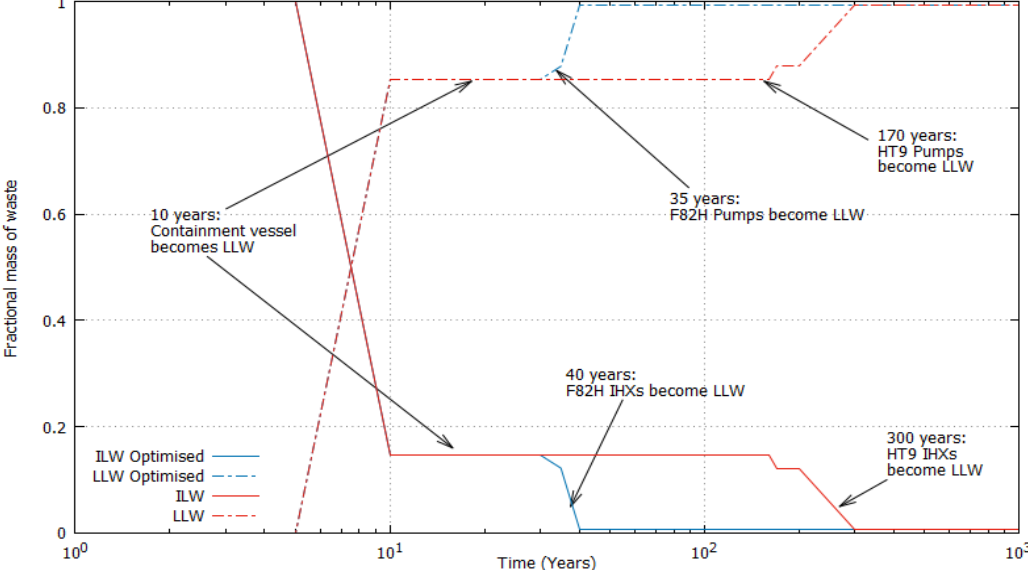
Figure 5. Mass of Low Level and Intermediate Level Waste Associated with the